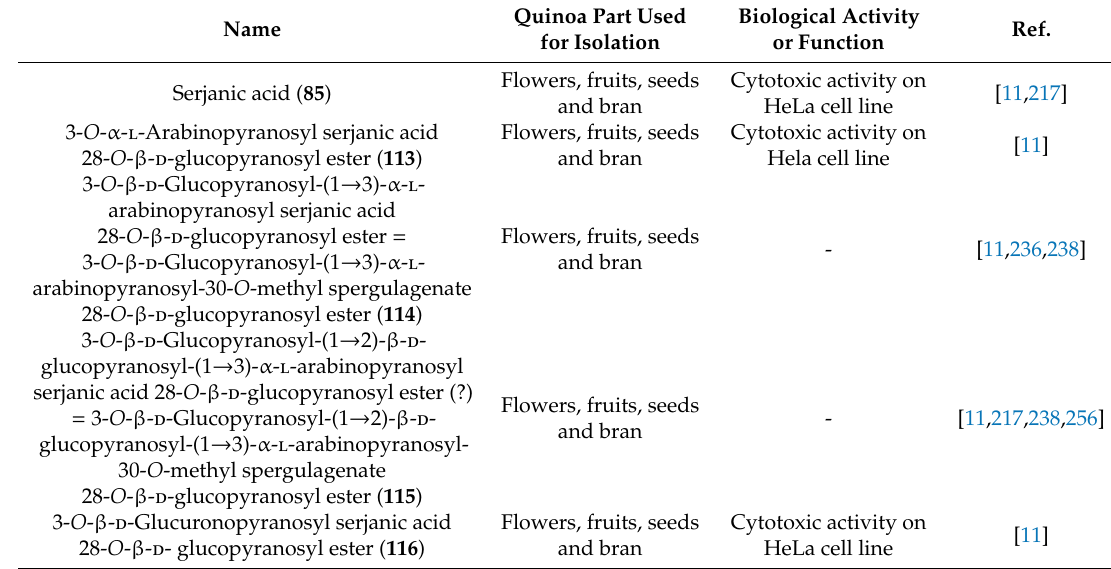
Table 12. Serjanic acid derivatives and their biological activities or